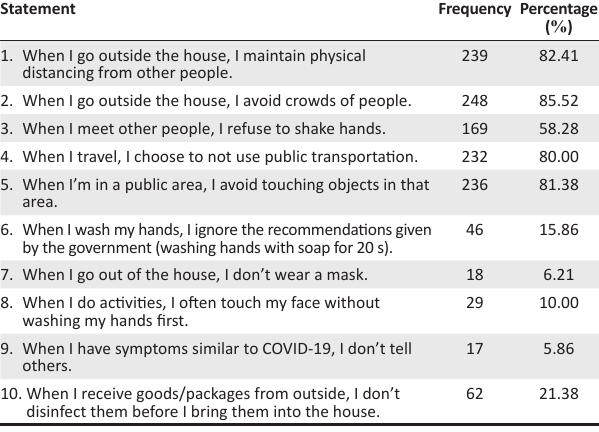
TABLE 6: Respondents’ answers related to preventive behaviour towards COVID-19 ( n = 290).